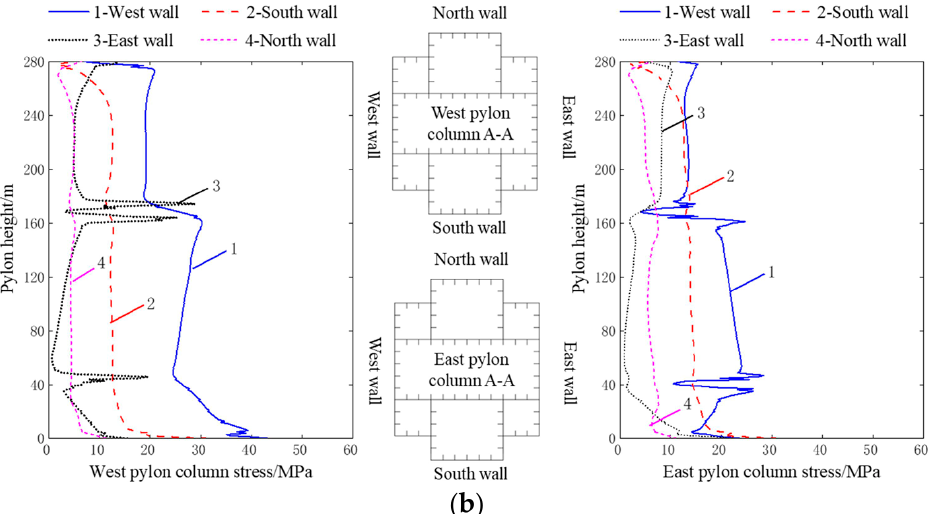
Figure 16. Stress curve of pylon in spring (autumn): ( a ) Thermal stress curve of cross-section A-A. ( b ) Vertical stress distribution of bridge pylon at 16:00.